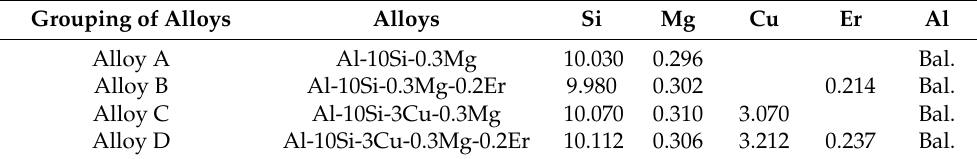
Table 1. Chemical composition and grouping of Al-Si alloys (wt.%). Grouping of Alloys